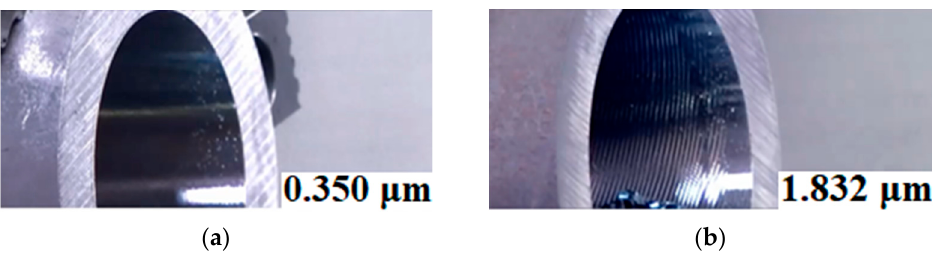
Figure 9. Arithmetic average roughness ( Ra ) for the workpiece when cutting with a carbide boring bar ( a ) in stable conditions at TSC = 4 mm − 1 ; ( b ) in unstable conditions at TSC = 13.50 mm − 1 .